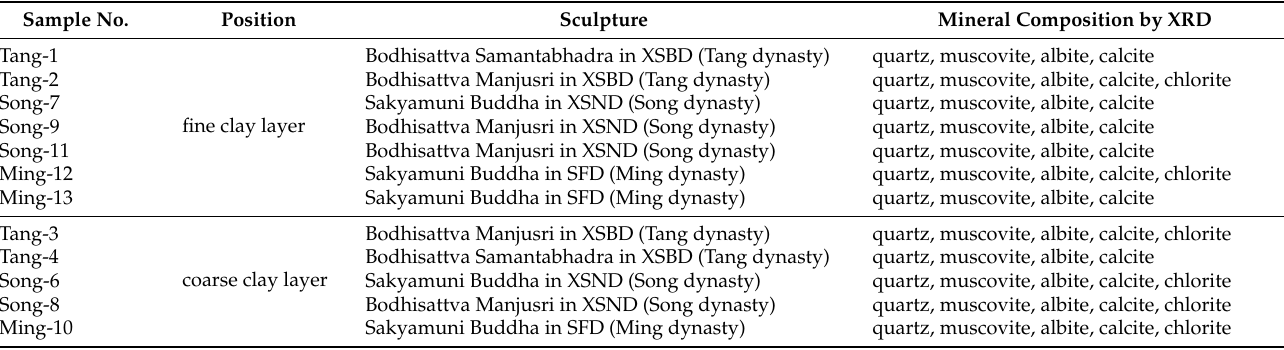
Table 1. Mineral composition of coarse and fine clay by XRD.